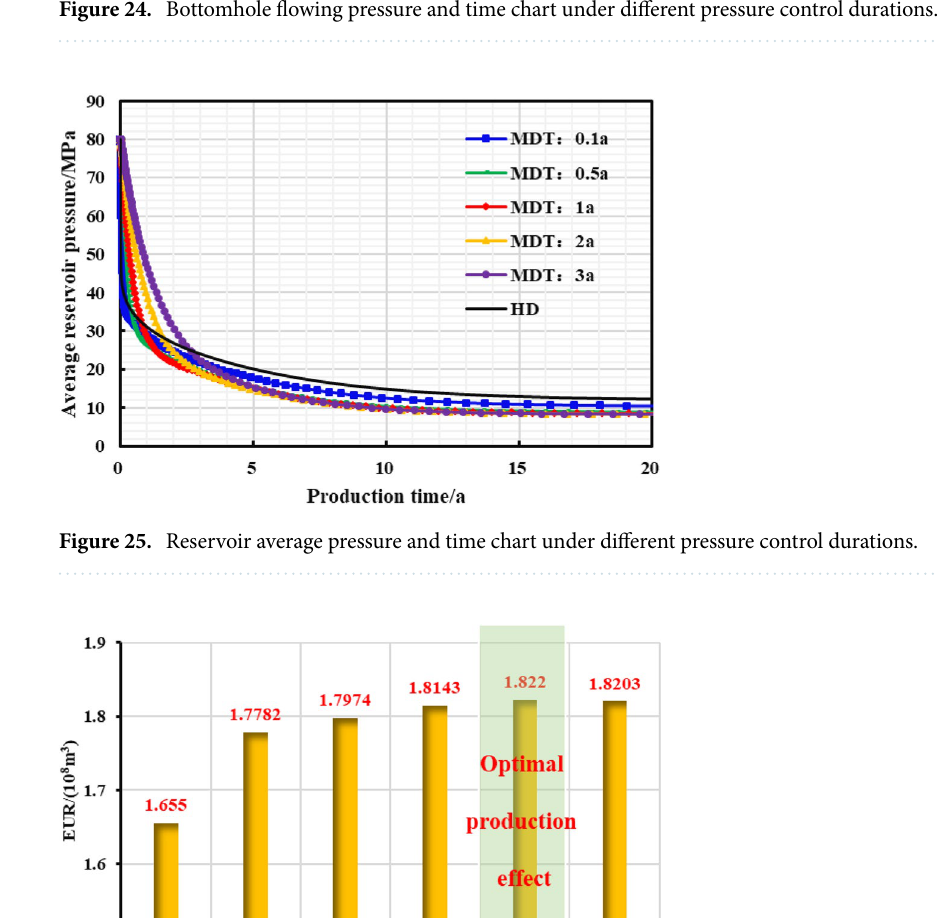
Figure 24. Bottomhole flowing pressure and time chart under different pressure control durations.